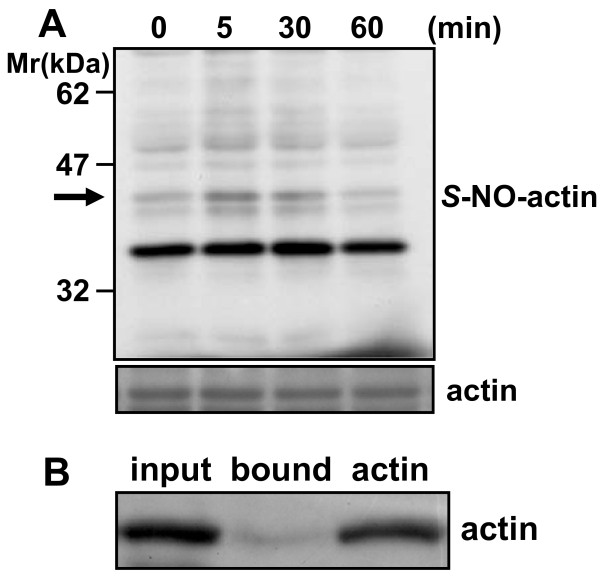
In vivo S-nitrosylation of actin in the spinal cord of inflammatory pain model. A. Time course of S-nitrosylation of proteins in the spinal cord. The dorsal spinal cords at the L3-L5 levels were dissected at 0, 5, 30 or 60 min after injection of 2% formalin (5 μl) into the hindpaws, and homogenates prepared. The soluble fraction of the homogenates was subjected to the biotin-switch assay. S-Nitrosylated and total actin were detected by anti-biotin and anti-actin antibodies, respectively, as described under "Methods." An arrow indicates the position of S-nitrosylated actin (S-NO-actin). B. Purification of S-nitrosylated actin on streptavidin-agarose. After the soluble fraction prepared from the dorsal spinal cord at 5 min after formalin injection was subjected to the biotin-switch method, S-nitrosylated proteins were purified on streptavidin-agarose. The eluate was resolved on 10% SDS-PAGE, and S-nitrosylated actin was detected with anti-actin antibody. Authentic actin (1 μg) was used as a positive control.